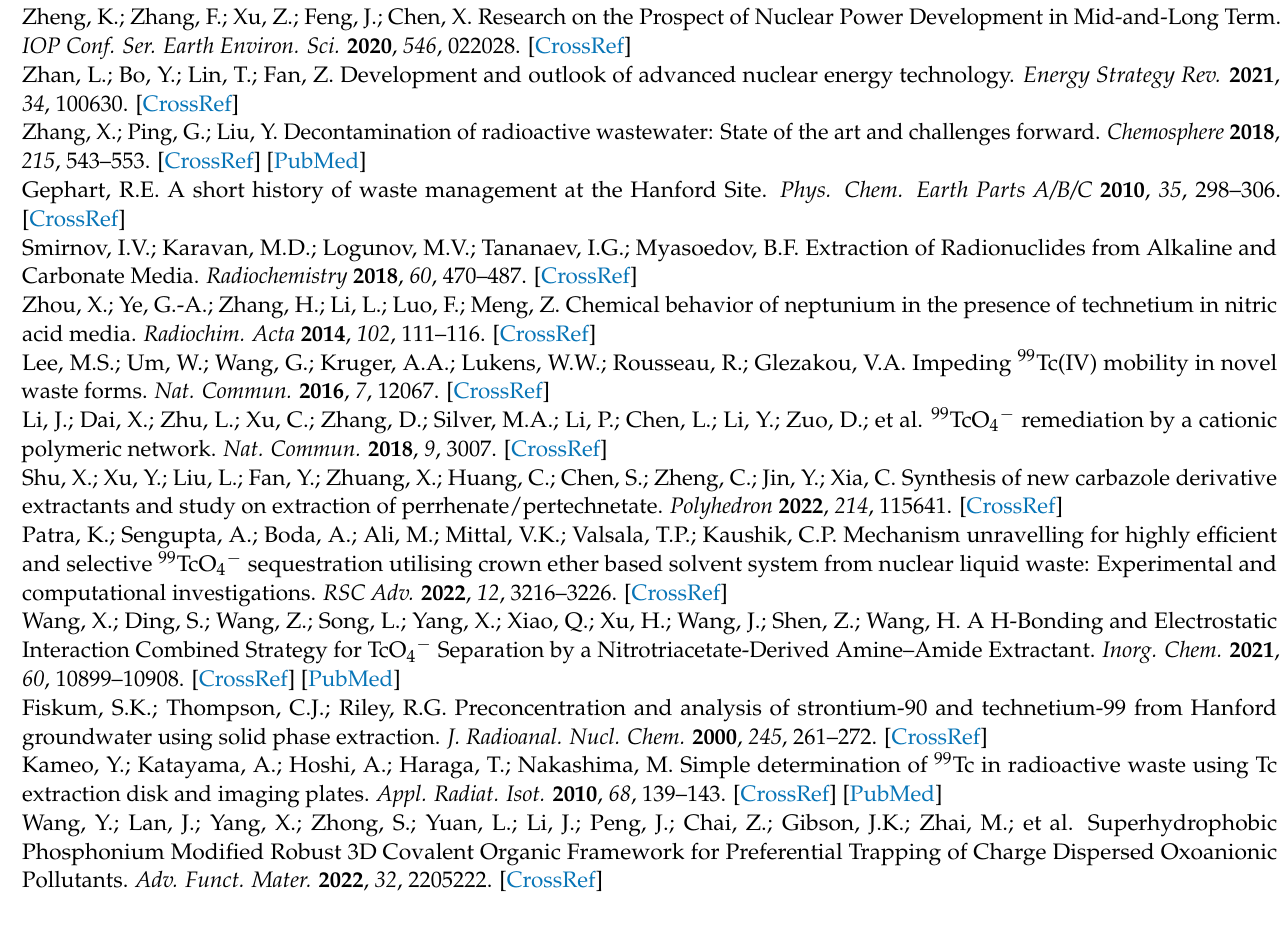
Figure S2b: XPS wide scan spectrum of